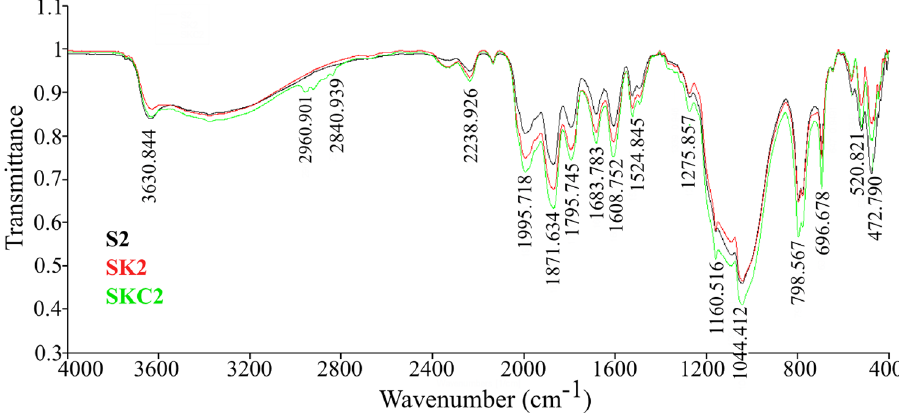
Fig. 5 FTIR spectra of the sam- ples S2, SK2, and